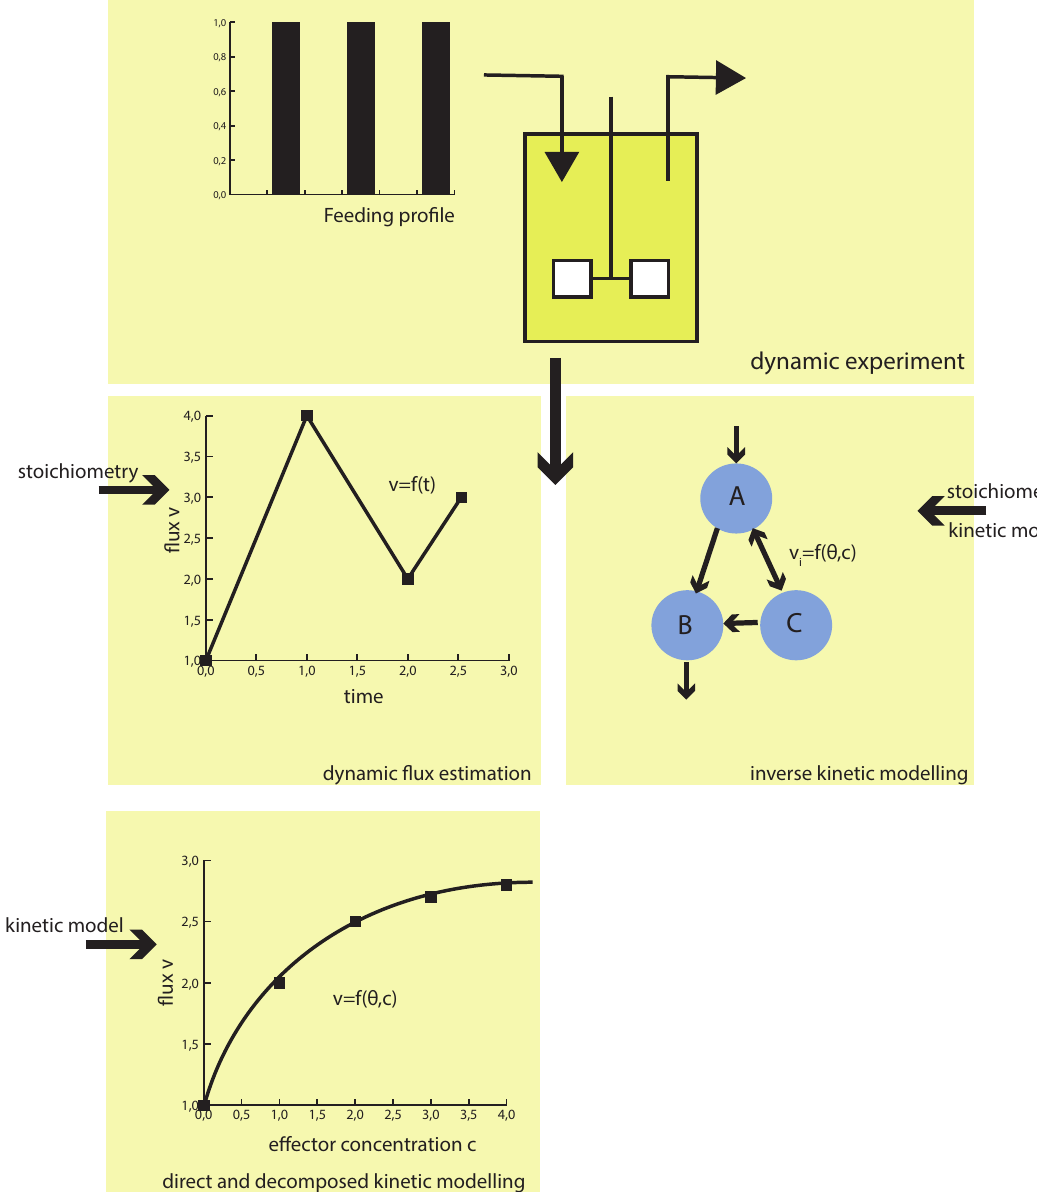
Figure 1. “Classical” kinetic modeling requires a priori defined kinetic mechanisms. Using the hybrid modeling approach, only the metabolic network structure (incl. atom transitions) is required a priori . As a result, the flux profile in time can be identified rather than kinetic parameters. With the flux functions on hand, the kinetics of the metabolic network can be investigated decoupled from the overall